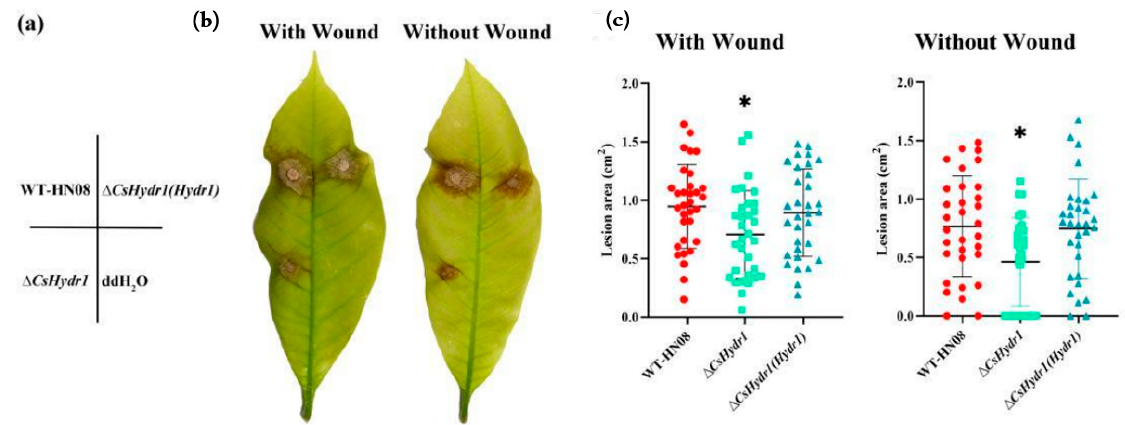
Figure 5. Virulence assays on rubber tree leaves. ( a ) Schematic diagram of the virulence assays of the tested strains. The rubber tree leaves were inoculated with 20 µ L of conidial suspension (1 × 10 5 spores/mL) of tested strains through unwounded and wounded ways; The symptoms ( b ) and dot plot analysis of the lesion areas ( c ) were shown at 5 days after inoculation. Thirty leaves were inoculated per treatment (* p < 0.1, according to one-way ANOVA and Duncan’s test; the error bar shows the standard deviation